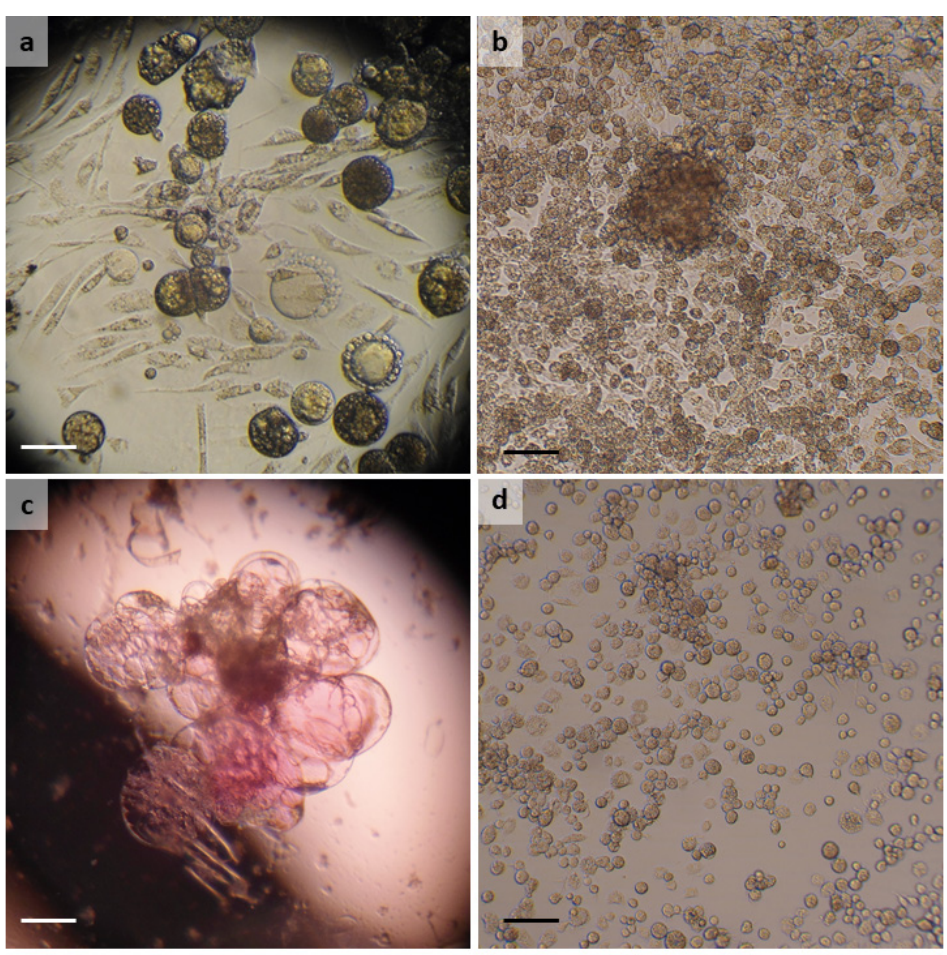
Figure 1. Argas reflexus and Dermacentor reticulatus cell lines. ( a ) A. reflexus primary culture 4 months post initiation showing large floating vacuolated cells, smaller attached spindle-shaped cells and small round haemocyte-like cells; live, inverted microscope; ( b ) A. reflexus cell line ARE/LULS41 at passage 8, 5 years post initiation; live, inverted microscope; ( c ) cluster of floating vacuolated cells in D. reticulatus primary culture, 15 months post initiation, showing pink colouring of some vacuoles; ( d ) D. reticulatus cell line DRE/LULS60 at passage 7, 3 years post initiation. Live, inverted microscope, scale bars = 100 µm.